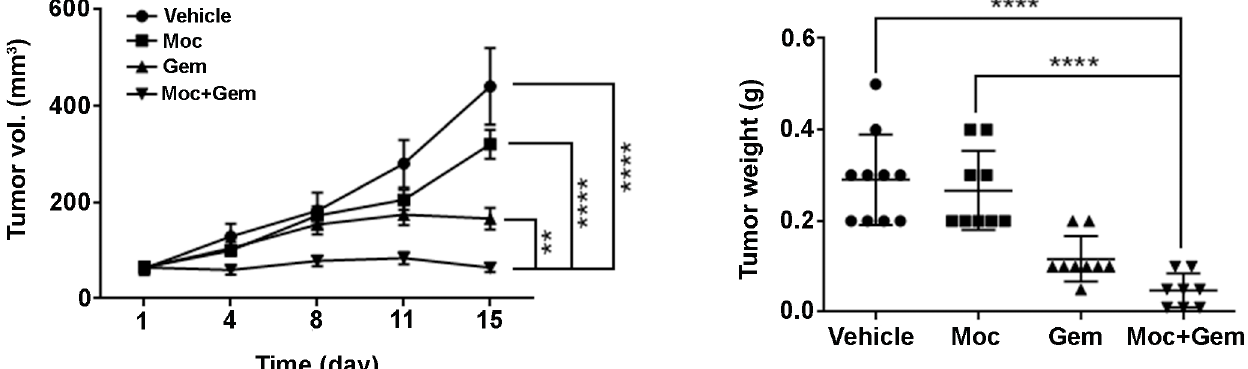
Fig 3. Mocetinostat combined with gemcitabine exhibits significant anti-LMS effect in vivo . Mocetinostat combinedwith gemcitabine significantly reducedtumor growth and tumor weight.